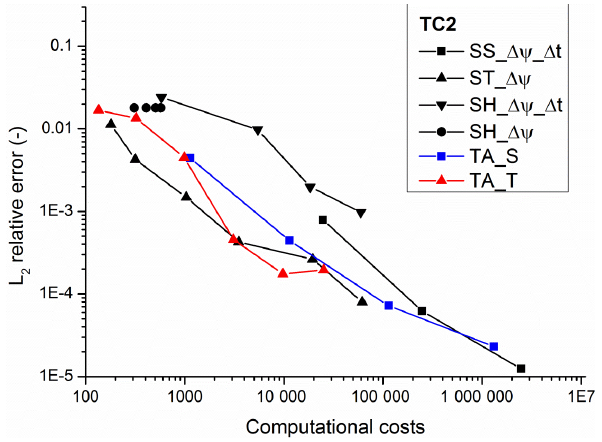
Figure 8. Evolution of the L 2 relative error with computational costs for